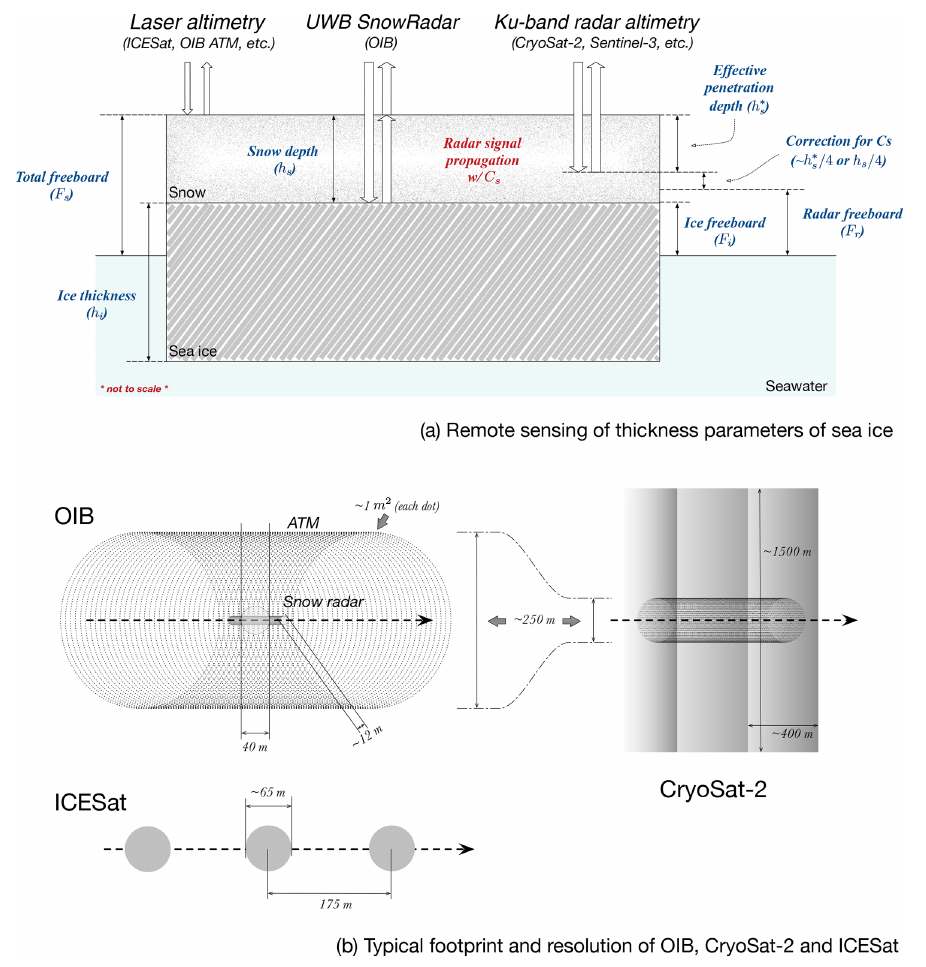
Figure 1. Sea ice remote sensing by CryoSat-2, ICESat and Operation